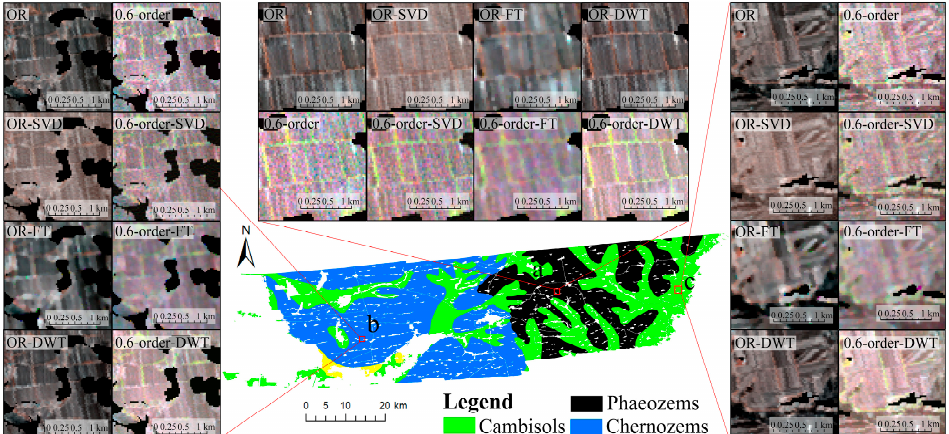
Figure 8. Images of the different soil classes under different denoising